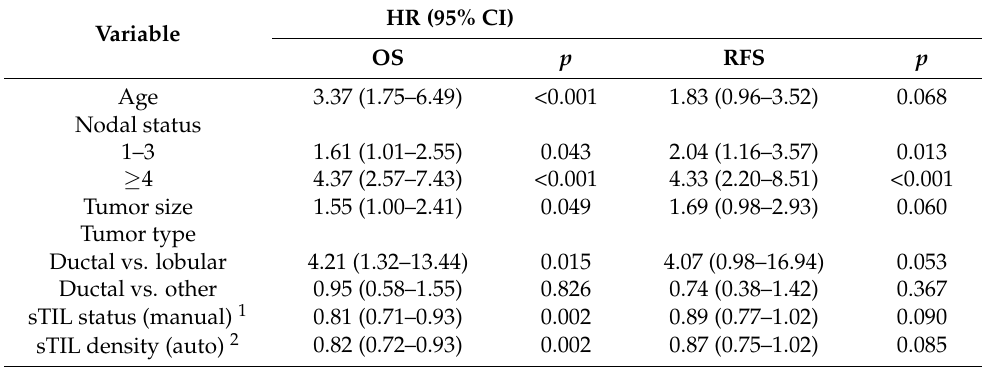
Table 1. Univariate analysis of the included clinical parameters and biomarkers. 1 Manual score is in